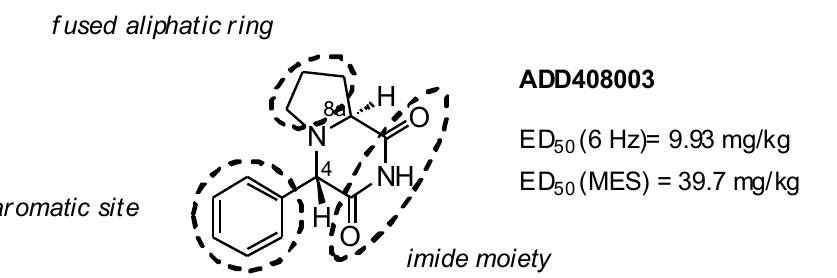
Figure 1. Structure of